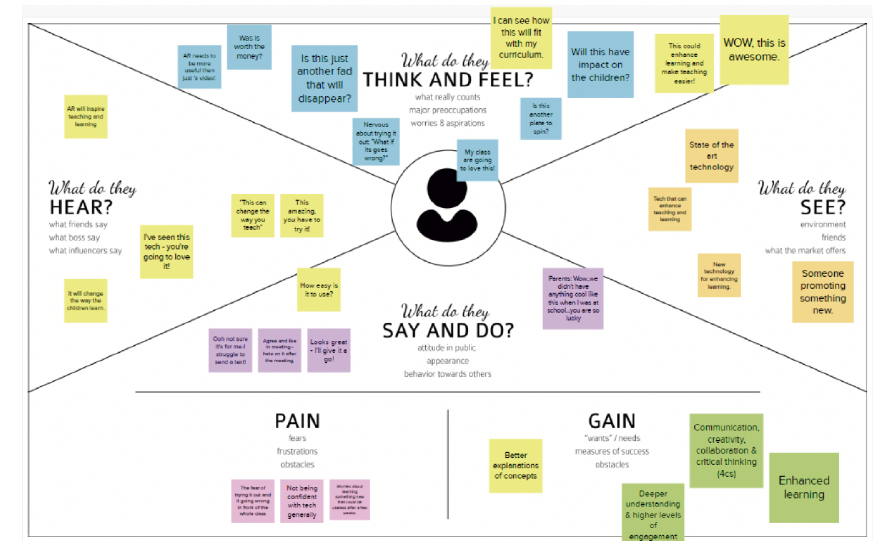
Figure 2. Empathy Map (Design Sprint)